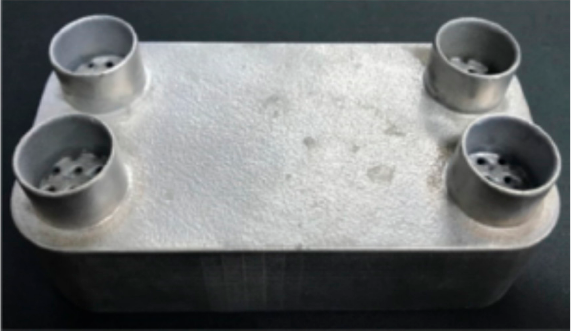
Figure 10. View of a heat exchanger printed in metal in research [47]. Table 2. View of design proposals for heat exchangers according to [47].